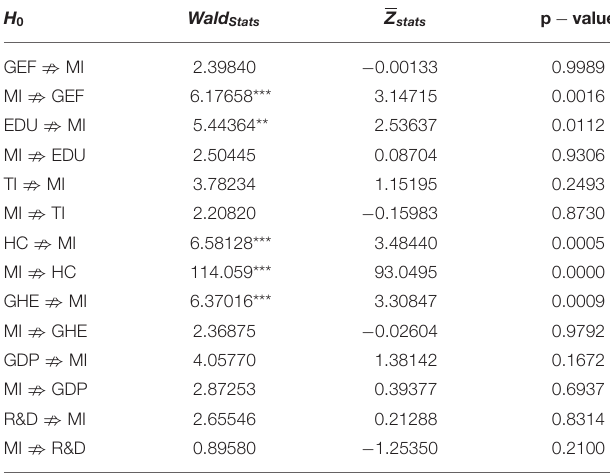
TABLE 9 | Estimates of quantile regression Model 2.